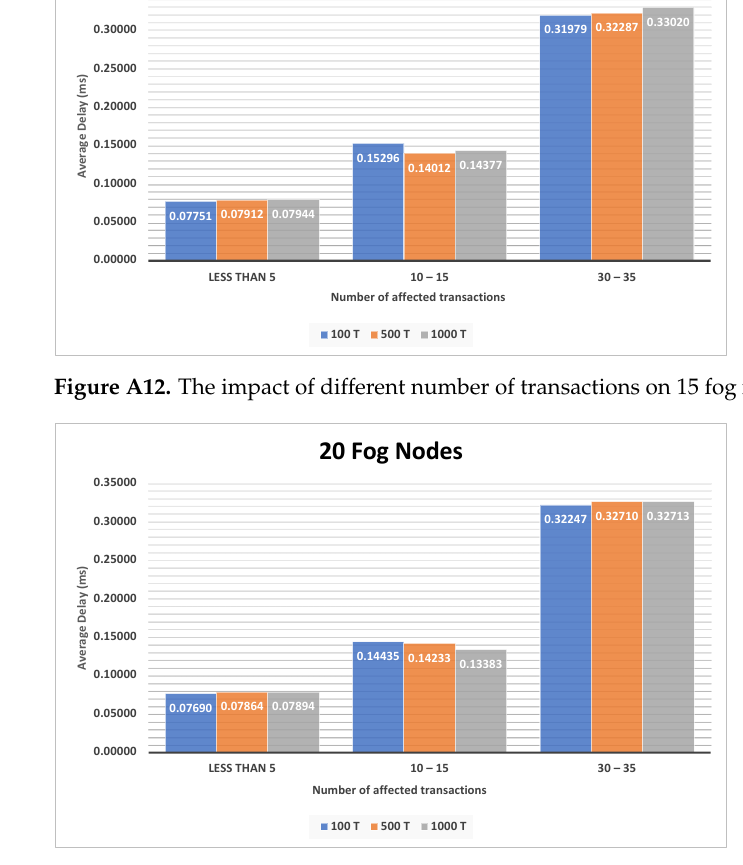
Figure A13. The impact of different number of transactions on twenty fog